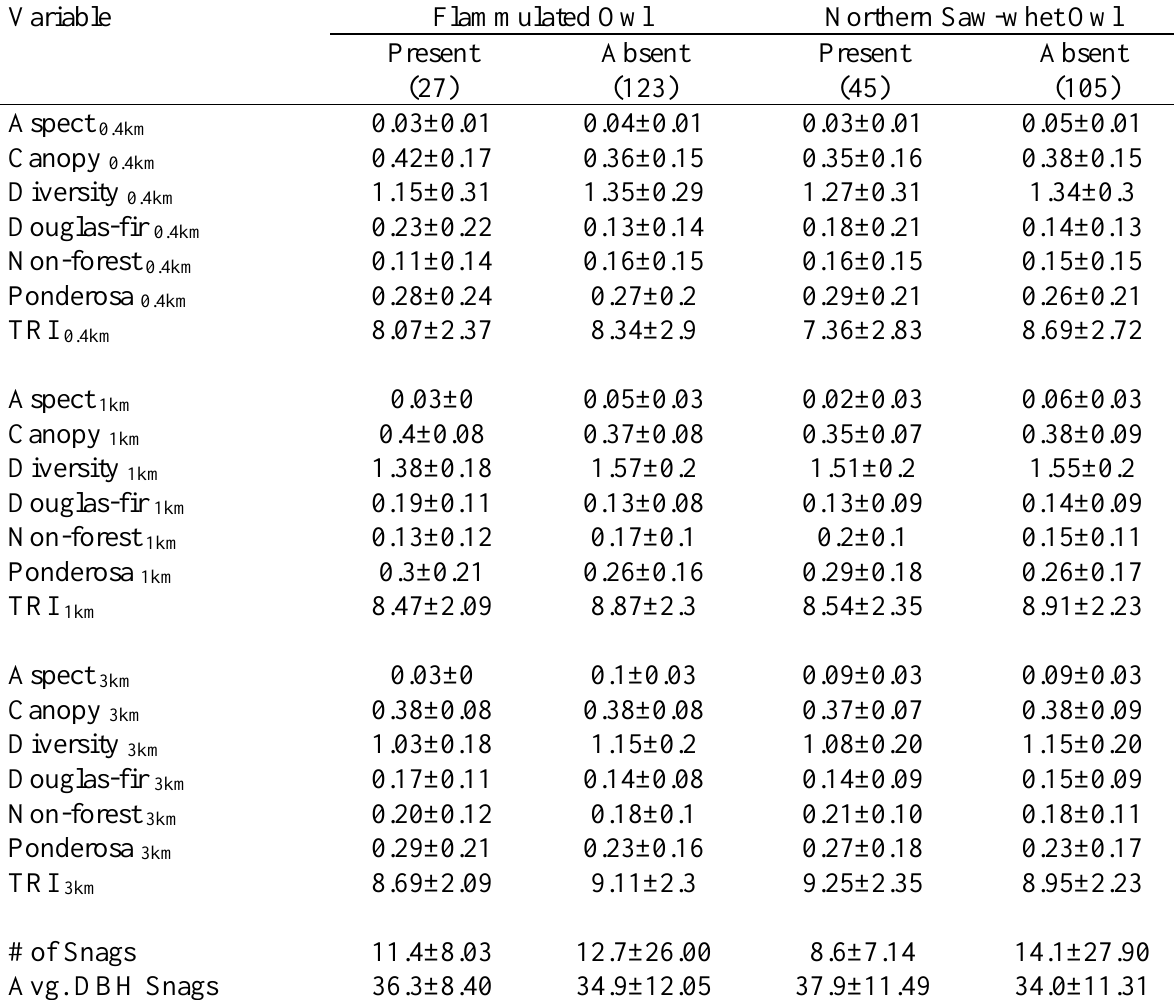
Table A1.2. Landcover and topographic variables ( 𝑥 ̅ ± SE) within 0.4-, 1- and 3-km radius circular plots surrounding point-count locations (n = 150) where cavity nesting owls were present and where they were absent in the Boise National Forest, Idaho, USA during 2009-2010. Proportion of canopy cover, Douglas-fir, non-forest, and ponderosa as well as landcover diversity, which was calculated as the Shannon Diversity Index, were derived from the LANDFIRE (2013) dataset. The topographic variable aspect was transformed using a cosine transformation and TRI (terrain ruggedness index) was expressed as the average elevational difference between adjacent cells in a digital elevation model (The National Map 2013). Snag characteristics were only measured at the 0.4 km-scale using 10m-wide belt transects centered on the point-count location and totaling 1km in